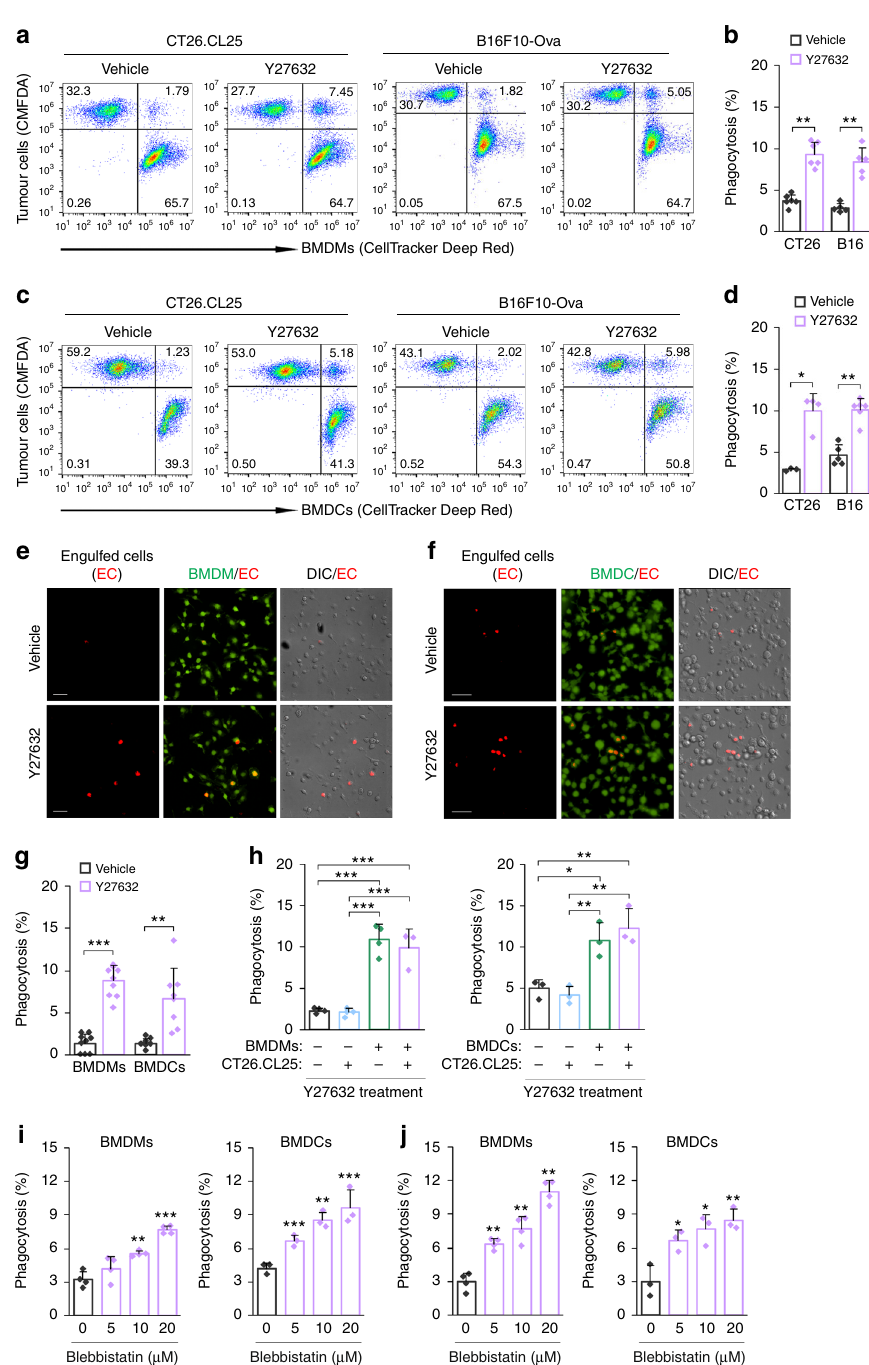
Fig. 1 ROCK blockade enhances cancer cell clearance by phagocytes. a – d CellTracker Deep Red-labelled BMDMs ( a , b ) or BMDCs ( c , d ) were co-cultured with CMFDA-stained CT26.CL25 or B16F10-Ova cells for 2 h in the presence of Y27632 (30 μ M) or vehicle (PBS), and then analysed by fl ow cytometry. Upper right quadrants indicate BMDMs or BMDCs harbouring cancer cells. a , c Representative fl ow cytometry plots. b , d Phagocytosis, calculated as the percentage of the total number of BMDMs or BMDCs containing cancer cells. Data are presented as means ± s.d. ( n = 3 – 6). e – g CMFDA-labelled BMDMs ( e ) or BMDCs ( f ) were co-cultured with pHrodo-labelled CT26.CL25 cells for 2 h in the presence of Y27632 or vehicle, and analysed under a fl uorescent microscope. e , f Representative images of BMDMs ( e ) and BMDCs ( f ) phagocytosing pHrodo-labelled CT26.CL25 cells. CMFDA-labelled BMDMs or BMDCs are shown in green, and engulfed CT26.CL25 cells are shown in red. Scale bar, 50 μ m. g Phagocytosis, calculated as the percentage of the total number of BMDMs or BMDCs containing cancer cells. Data are presented as means ± s.d. ( n = 8 – 10). h CellTracker-labelled BMDMs (left panel) or BMDCs (right panel) were co-cultured with CMFDA-stained CT26.CL25 cells for 2 h under the indicated conditions, and phagocytosis (%) was analysed by fl ow cytometry. Data are presented as means ± s.d. ( n = 3 – 4). i , j CellTracker-labelled BMDMs (left panels) or BMDCs (right panels) were